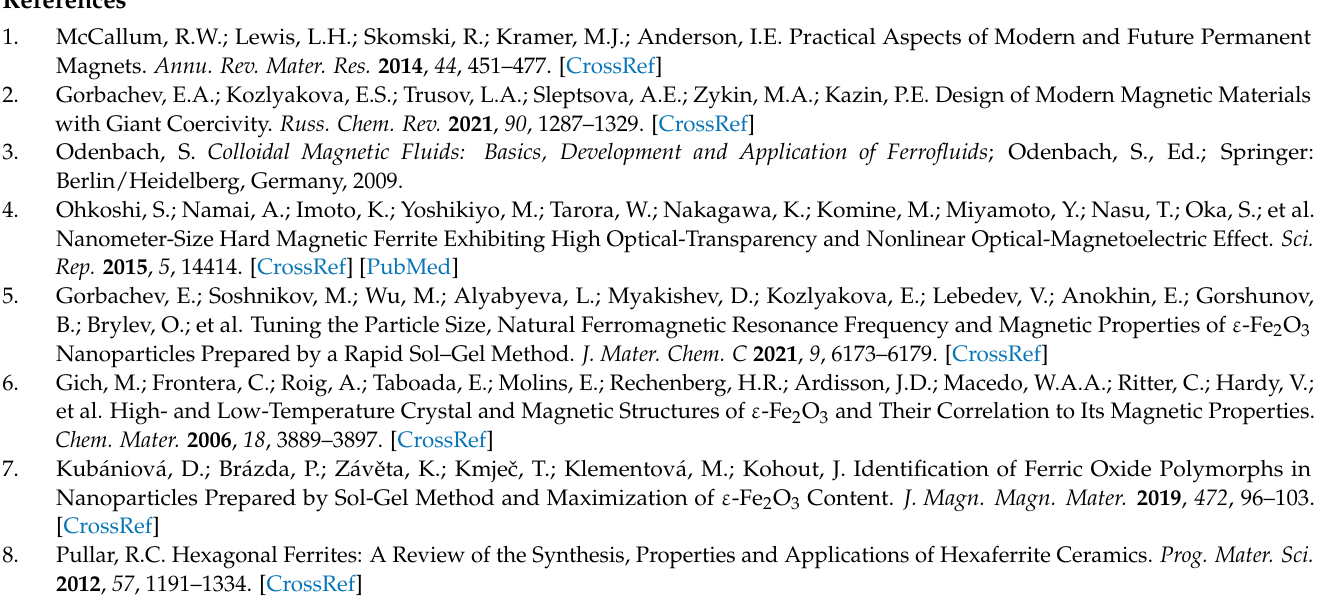
Figure A4. Particle thickness distributions of FO_32 and FO_11 composite samples obtained from TEM data.